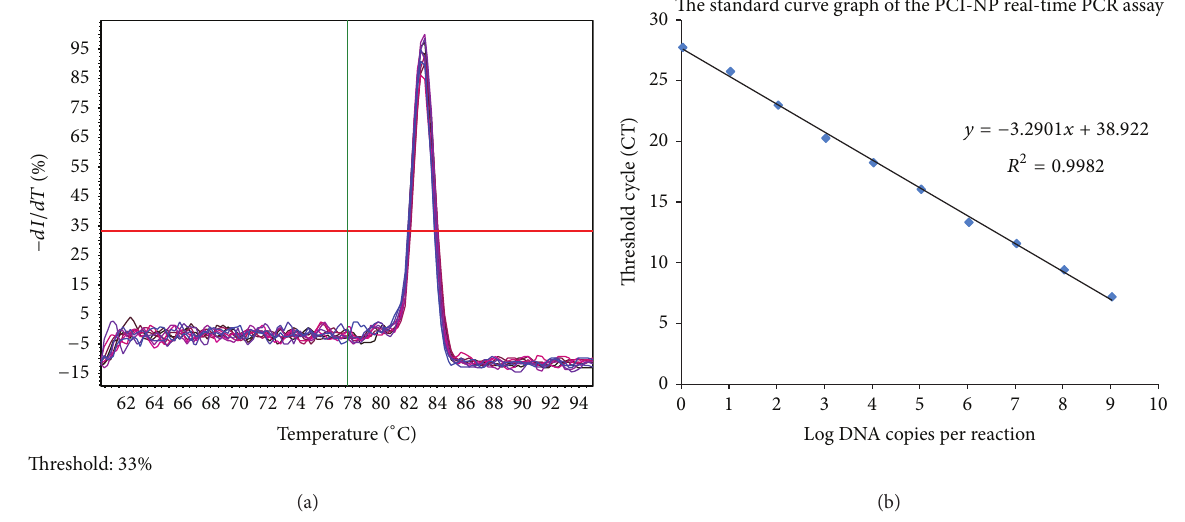
Figure 2: The development of a real-time quantitative PCR assay for absolute quantification. (a) Melting curve, (b) linear regression equation. The amount of plasmid T-NP was converted into copy number via the following equation: copy number = (amount of T-NP × 6.022 × 10 23 )/(length of T-NP × 10 9 × 660). The linearity of the standard curve was retained when the plasmid concentration was in the range of 5.5 × 10 2 –1.1 × 10 9 copies/ 𝜇 L. The obtained linear regression equation was 𝑌 = −3.2901𝑋 + 38.922 ( 𝑅 2 = 0.998). The amplification efficiency was 101%.